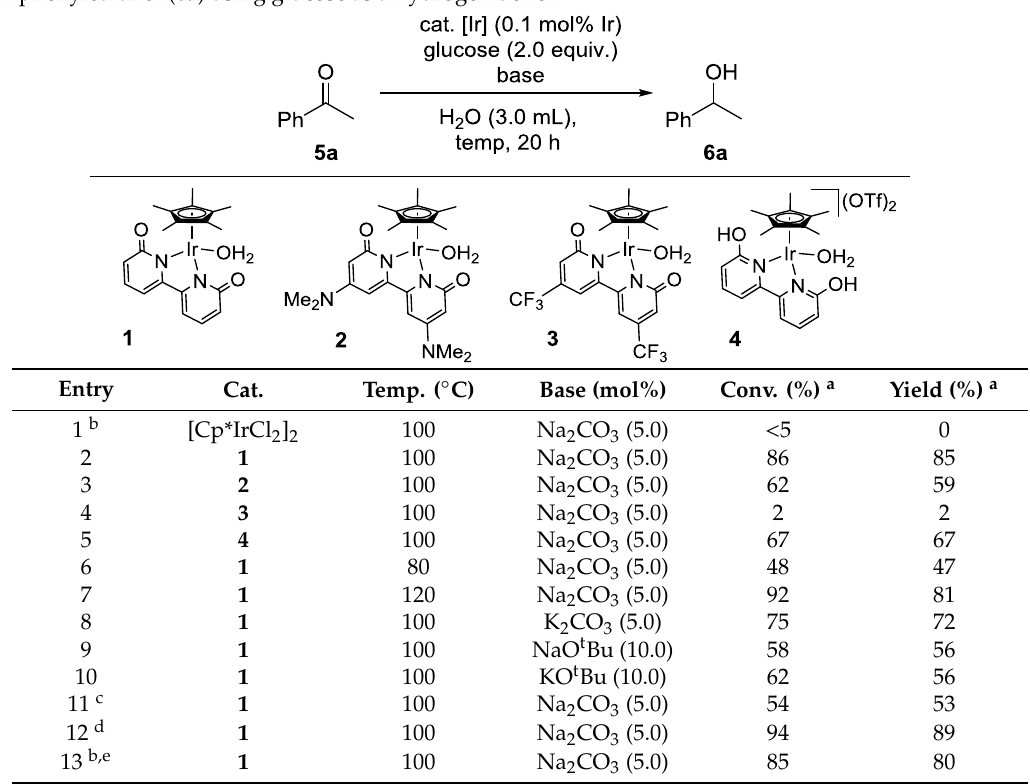
Table 1. Optimization of reaction conditions for the transfer hydrogenation of acetophenone ( 5a ) to 1-phenylethanol ( 6a ) using glucose as a hydrogen donor.